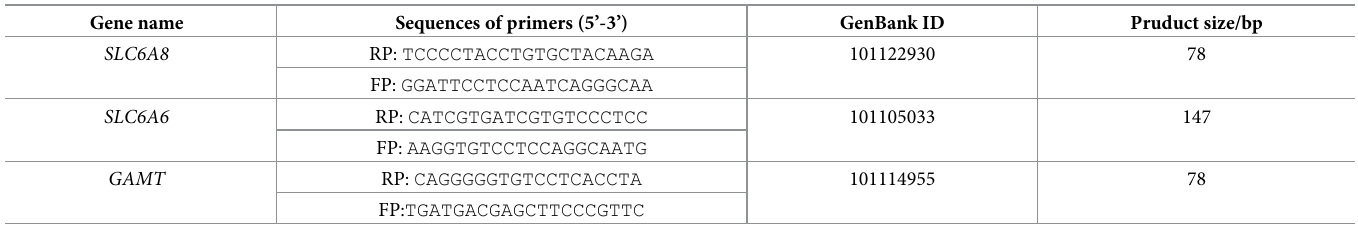
Table 2. Sequences and parameters of primers for the real-time fluorescence quantitative PCR.